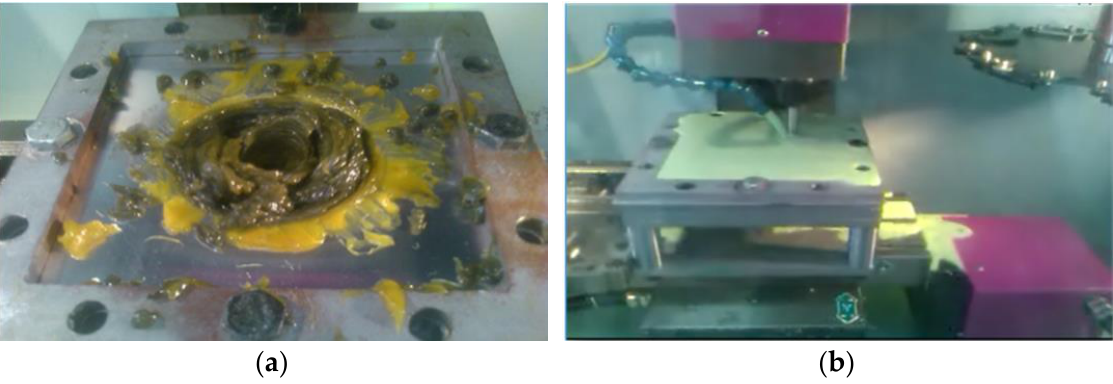
Figure 5. ( a ) Forming process using grease, ( b ) forming process using coolant oil.